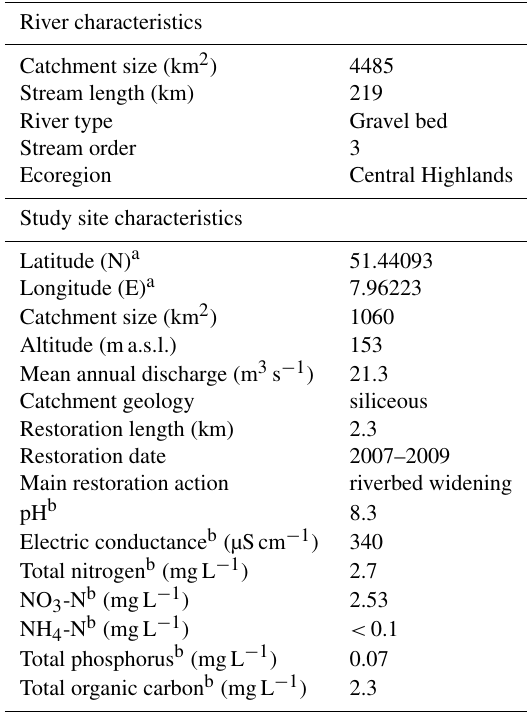
Table 1. River and study site